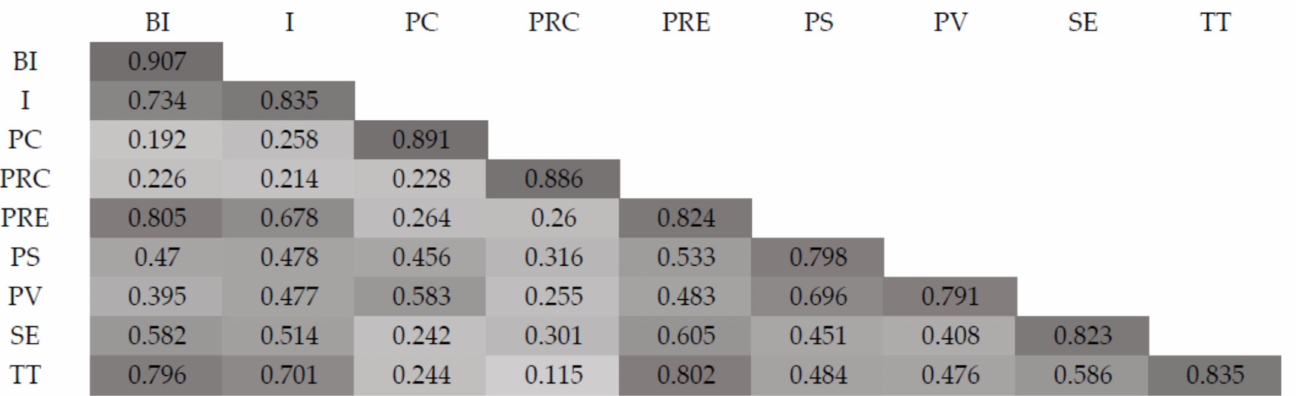
Figure 5. Discriminant validity (diagonal values show AVE square root).